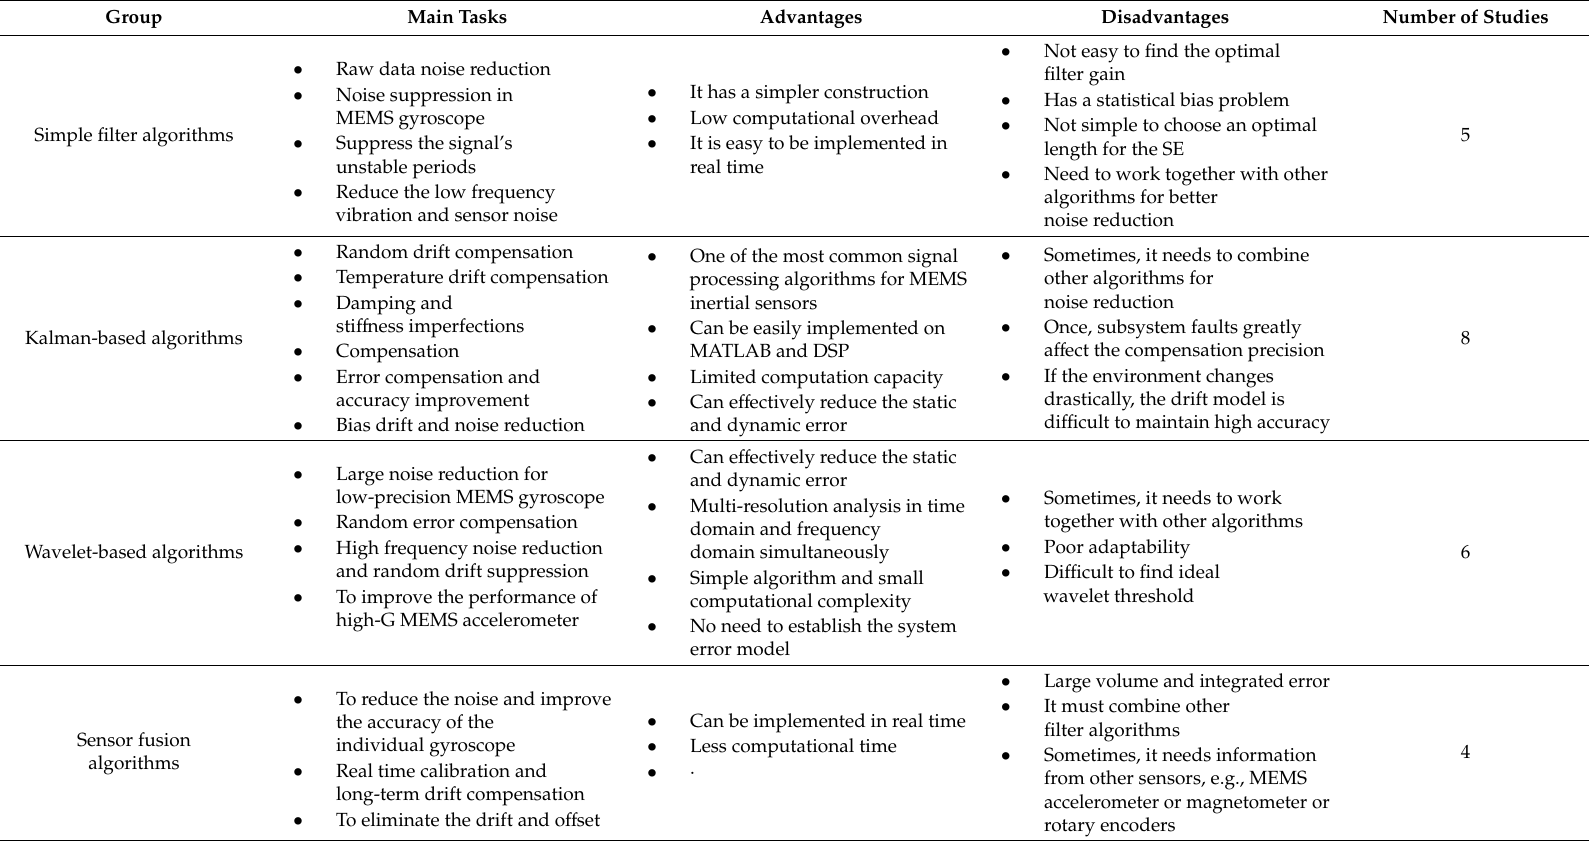
Table 3. Comparative analysis of algorithms based on group classification and their merits.